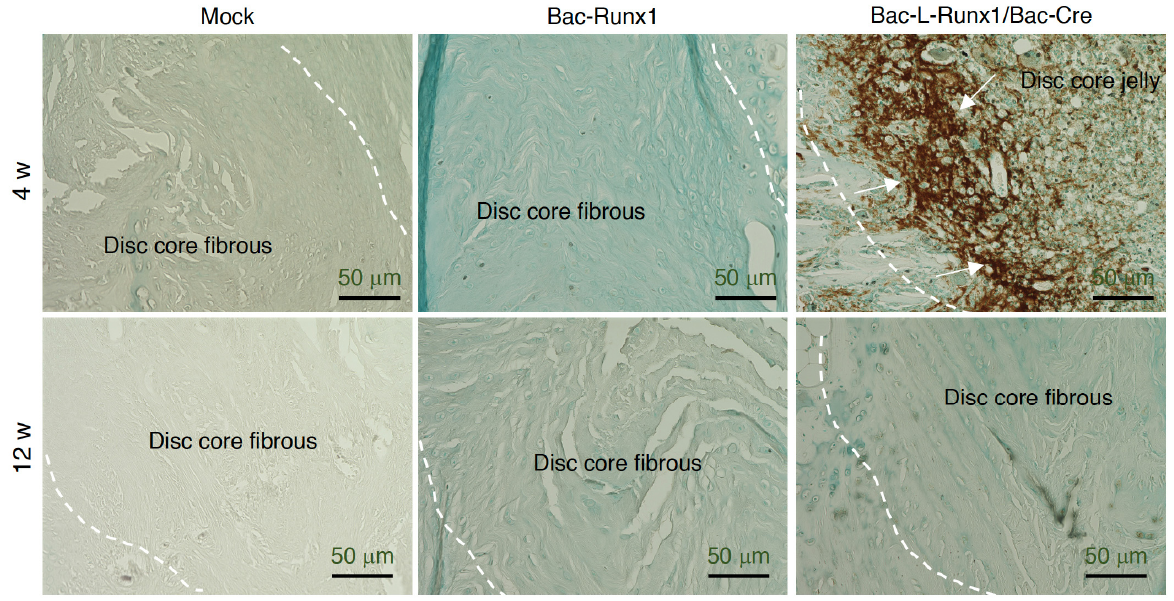
Figure 8. Immunohistological staining to detect the FLAG signals. Recombinant runx1 expressed from Bac-Runx1 or Bac-L-Runx1/Bac-Cre transduction was detected by FLAG signals to discrimi- nate the exogeneous runx1 from BMSCs’ endogenous runx1 expression. At 4w and 12 w post-trans- plantation, sections retrieved from the middle part of the disc were immunostained with 1st anti- body against FLAG, followed by HRP and DAB staining. A dashed line indicates the tissue margin between AF and NP. Arrows indicate the deep intensity of DAB staining in the disc core.